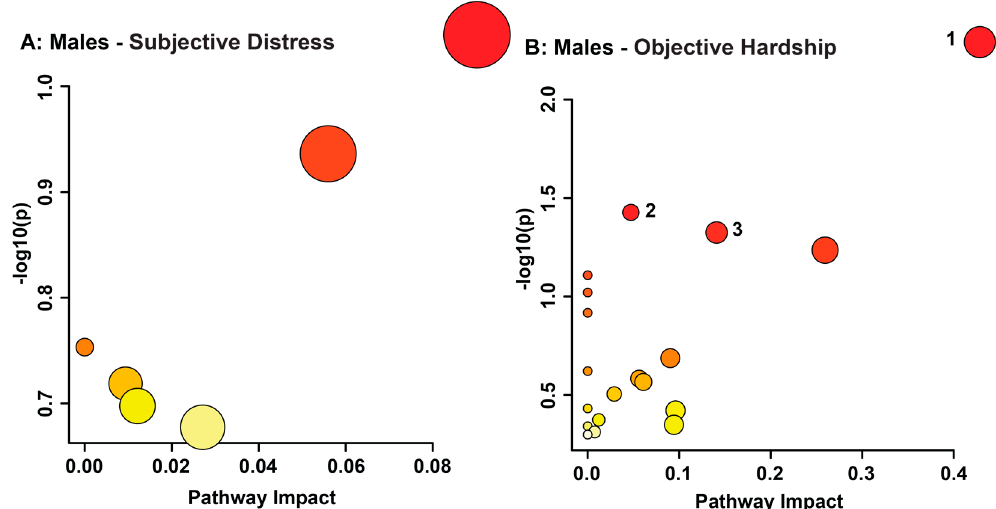
Figure 3. Metabolomic Pathway Topology Analysis of males whose mothers experienced composite subjective distress ( A ) and objective hardship ( B ) conducted utilizing bins identified as significantly altered by VIAVC. A higher value on the y-axis relates to a lower p -value, with 1.3 referring to a p - value of 0.05. The x-axis provides a measure of the predicted impact on the metabolic pathway due to the identi fi ed metabolites. The color of each circle is indicative of its p -value, whereas the size of each circle relates to its impact factor, with a darker color and larger circle indicating a lower p -value and greater impact factor, respectively. Only the pathways with a signi fi cant p -value (less than or equal to 0.05) are numbered and refer to the following metabolic pathways: (1) Taurine and hy- potaurine metabolism; (2) Pentose phosphate pathway; and (3) Lysine degradation.